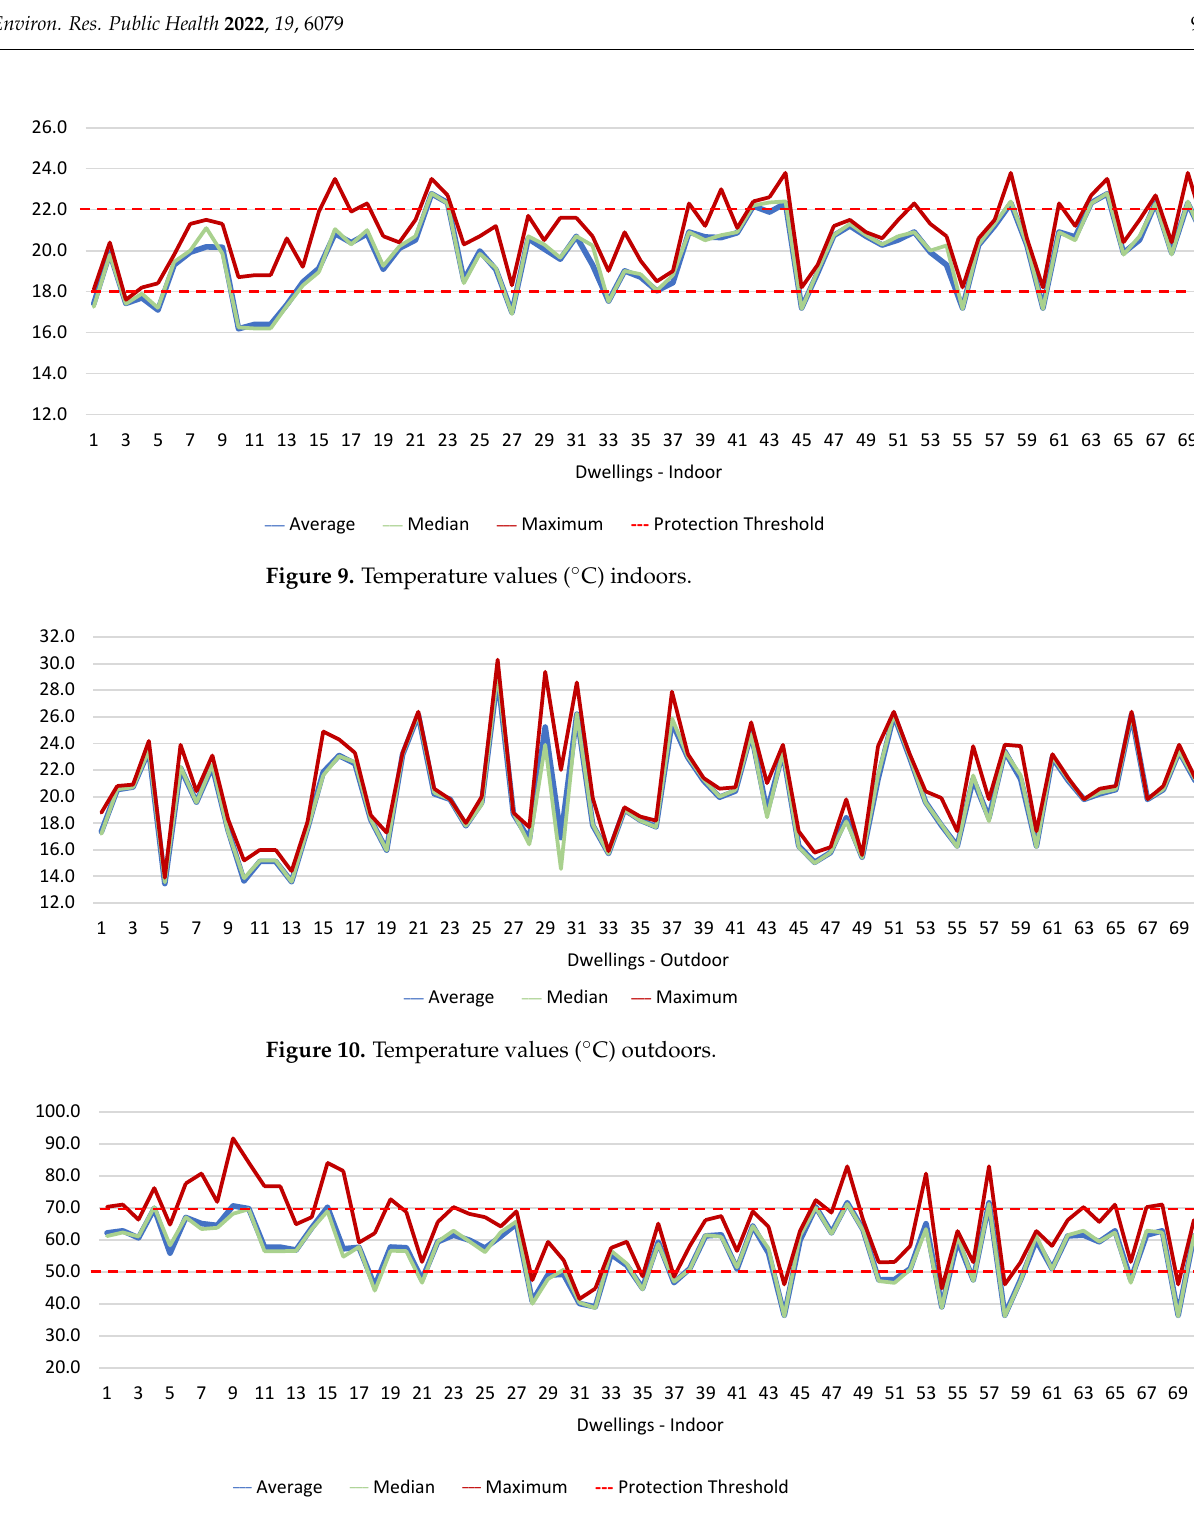
Figure 11. Relative humidity values (%) indoors.